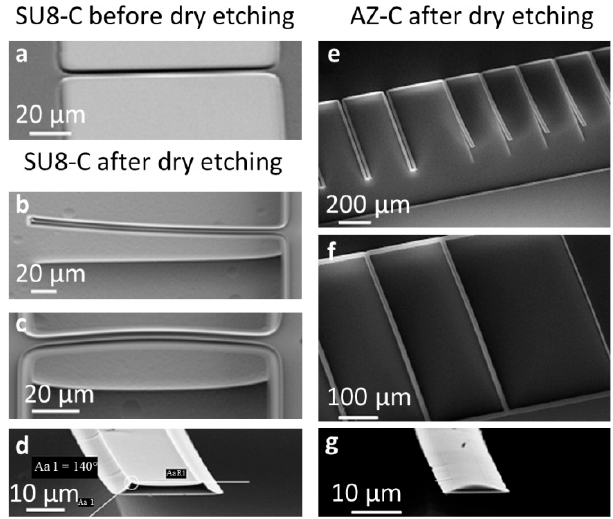
Figure 3. SEM pictures of the structures obtained with the “ pyrolysis-dry etch ” strategy. ( a ) Unreleased SU8-C resonator ( L = 100 µm, w = 14 µm) after pyrolysis; ( b ) Released SU8-C cantilever ( L = 200 µm, w = 14 µm); ( c ) Doubly-clamped SU8-C beam ( L = 100 µm, w = 14 µm); ( d ) Curved sidewalls of the cross-sectional profile of SU-8 cantilevers ( w = 14 µm); ( e ) The widest pyrolyzed AZ cantilevers ( left , L = 500 µm, w = 50 µm) were not released compared to the more narrow ones ( right , L = 500 µm, w = 30 µm); ( f ) AZ-C doubly-clamped beams ( L = 500 µm, w = 14 µm ( left ) and w = 6 µm ( right )); ( g ) AZ-C cantilever (100 µm long, 14 µm wide) with a rounded profile due to the reflow of the photoresist. All dimensions are nominal mask dimensions.